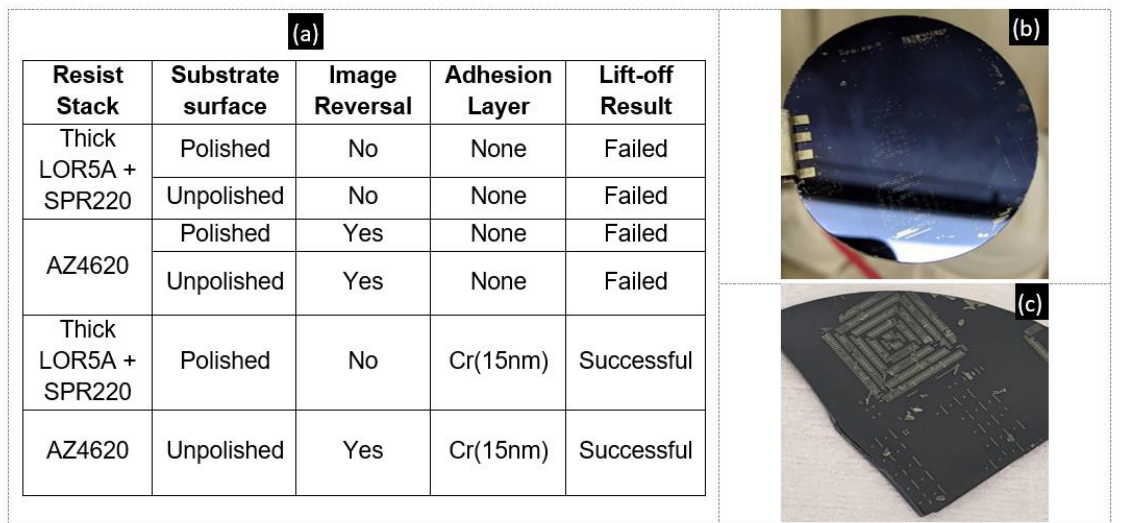
Figure 8. ( a ) Table tracking the combinations of adhesion layers, resists, and substrate surfaces for lift-off. ( b ) Failed lift-off on a polished surface of a 2” Si/SiO 2 wafer. ( c ) Failed lift-off on an tested for lift-off. ( b ) Failed lift- off on a polished surface of a 2” Si/SiO 2 wafer. ( c ) Failed lift-off on an unpolished surface. unpolished